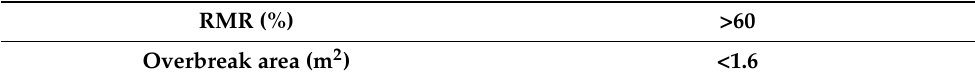
Table 3. Threshold values for determining technological overbreaks. RMR (%) >60 Overbreak area (m 2 )